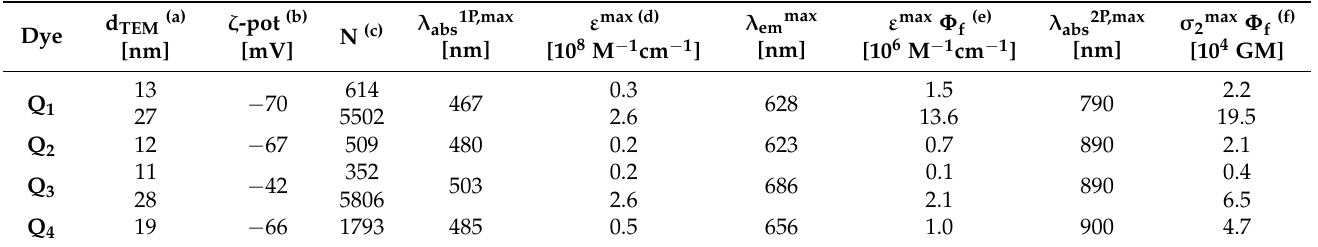
Figure 5. Representative TEM images of dyes Q 1 –Q 4 and corresponding size distribution (inserts). Table 3. Structural and optical properties of FONs made from quadrupolar derivatives Q1 – Q4